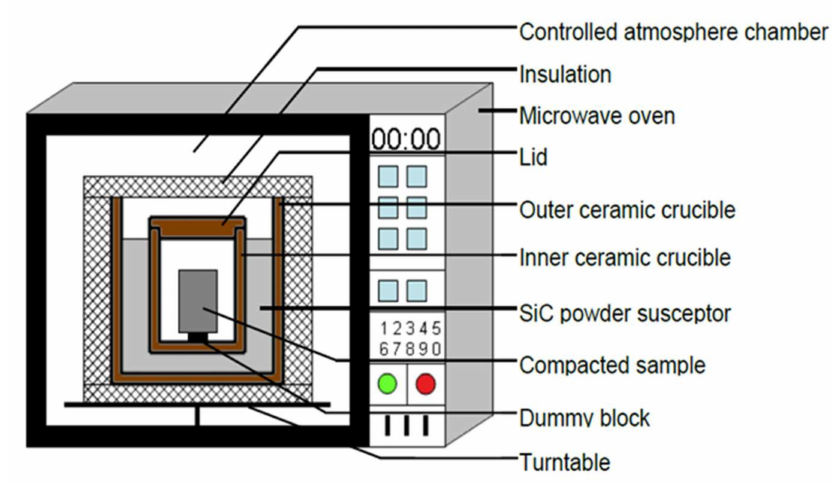
Figure 3. Schematic of set-up showing bi-directional microwave